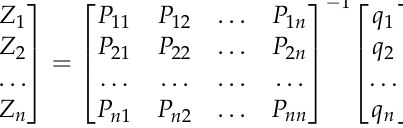
Figure 6. Radiation pattern for arbitrarily steering beams. We were able to steer a single beam to almost any direction while retaining its shape. The directivity was varied with an accuracy of 0.1°. Thus, the performance of steerable single beamforming is well proven with high accuracy. The beam presented in Figures 7 – 10 was created to study the three-dimensional ra- diation pattern. This was carried out considering the dipole elements as half-wave dipoles and a randomly selected angle of 30°. The 3D space views of the obtained beam are pre- sented in Figures 7 – 10 with the different positions.